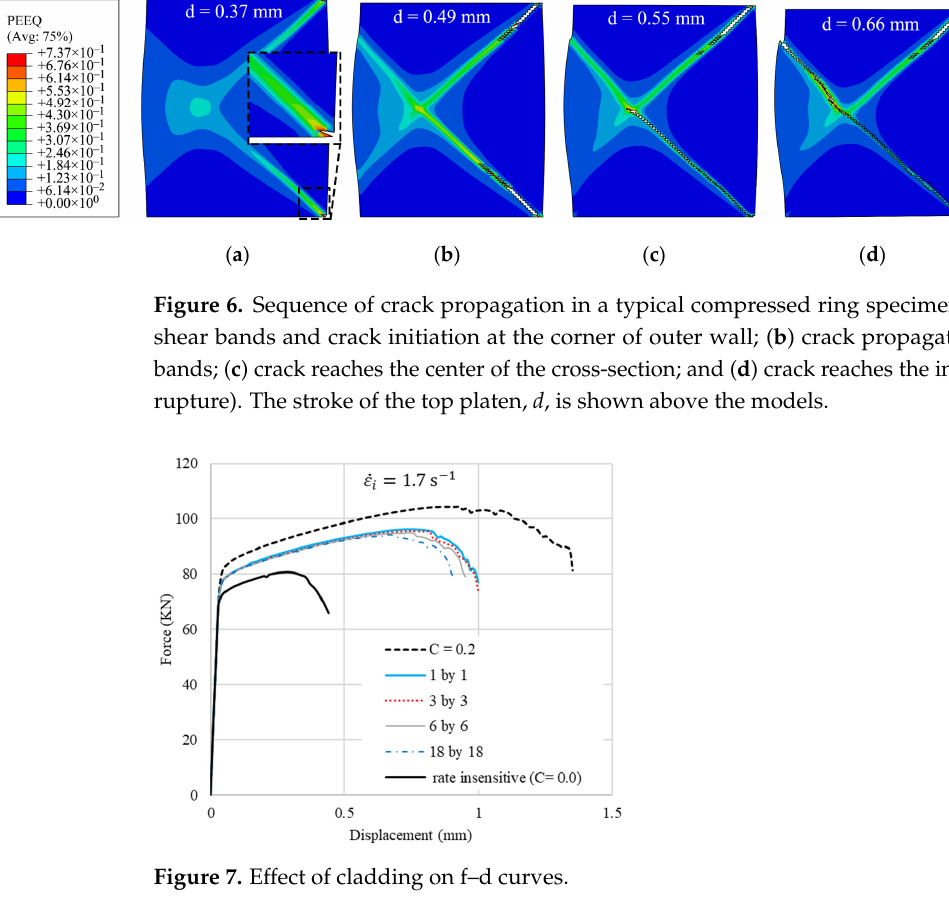
Figure 7. Effect of cladding on f–d curves.